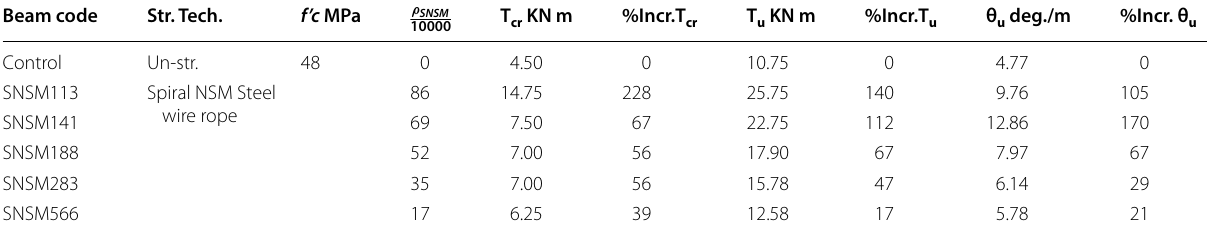
Table 4 Experimental results of the tested beams.